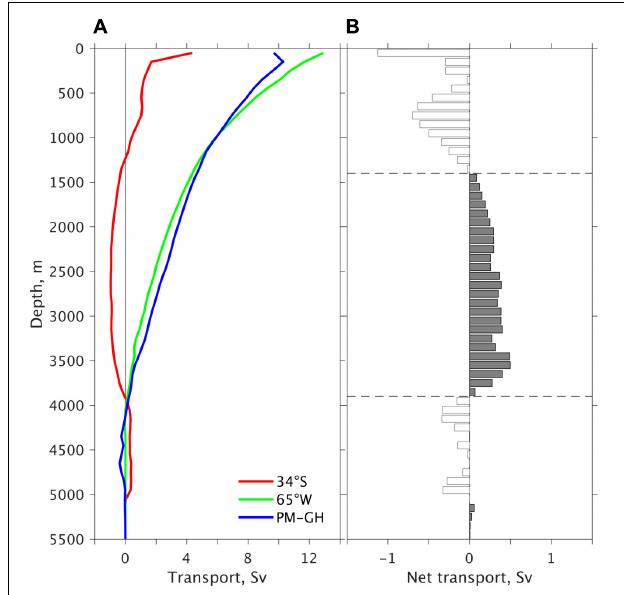
FIGURE 8 | (A) Modeled mean horizontal transports (Sv per 100 m) in the vertical across the 34 ◦ S, the 65 ◦ W, and the PM-GH transects; (B) The net transports into the region enclosed by the three transects, with positive (negative) values indicating net transport into (out of) the